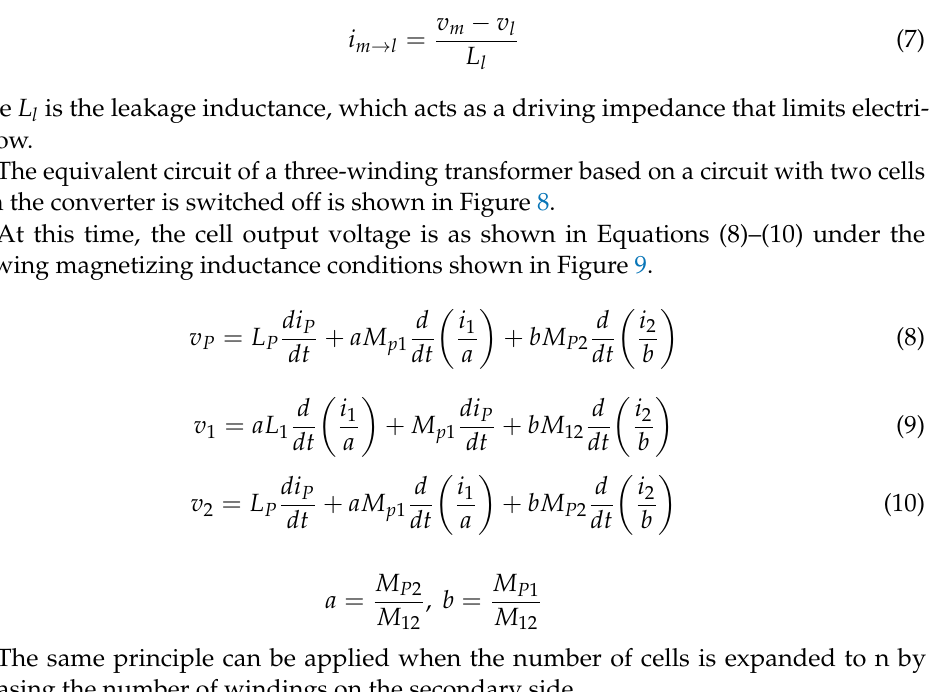
Figure 8. Voltage balancing between cells.